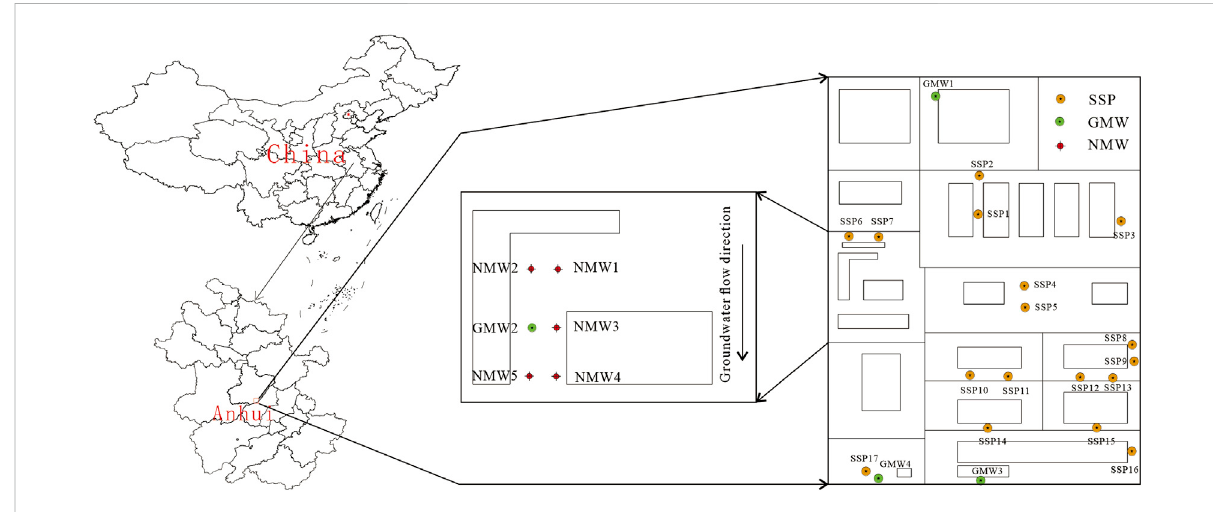
FIGURE 1 Locations of the soil sampling points and groundwater monitoring wells in the